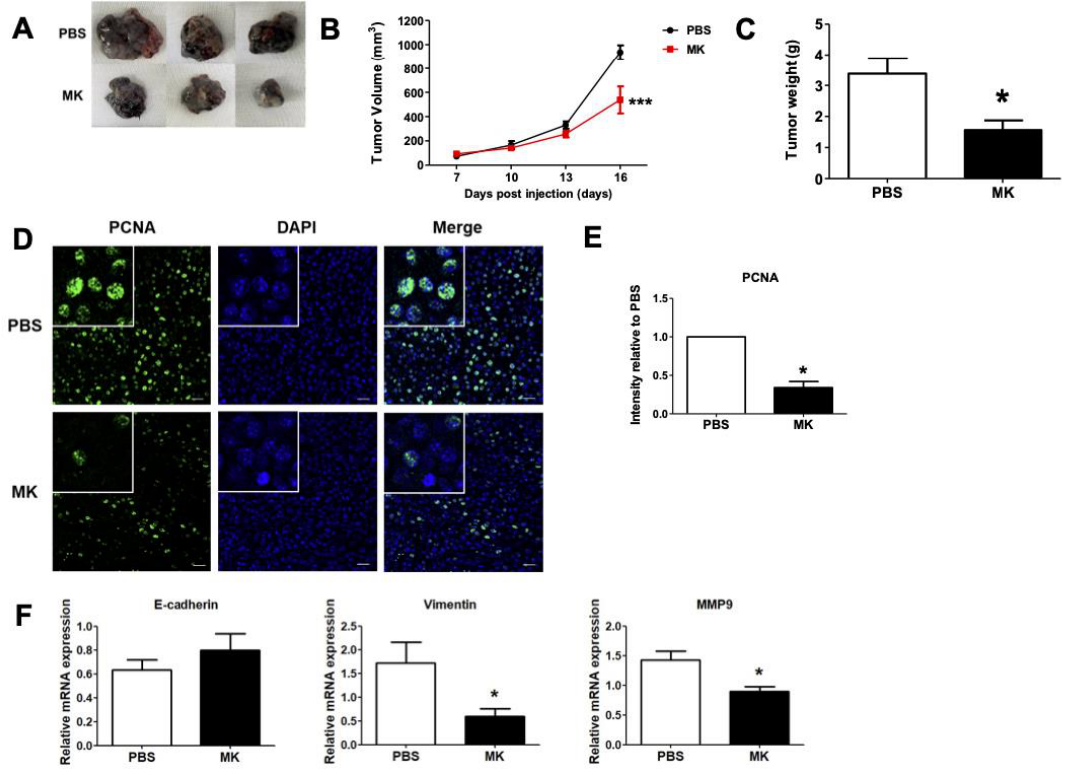
Figure 6. Inhibition of tumor growth by melittin–dKLA in a mouse model of melanoma. ( A ) Images show the tumor tissues from the mouse model. ( B ) The volume of the tumor was measured by a digital caliper and calculated using the formula V = (Width (2) × Length)/2. ( C ) The tumor weight of mice was measured by electronic scale after sacrifice. ( D ) Expression of PCNA in tumor tissues was determined by immunofluorescence staining assay. Confocal images of a tumor tissue slice stained for PCNA (green) and nucleus (DAPI; blue). ( E ) The graph is presented as intensity relative to PBS. ( F ) Expression of E-cadherin, vimentin, and MMP9 mRNA in tumor tissues was analyzed by quantitative real-time PCR. All data are presented as means ± SD ( n = 5); * p < 0.05, *** p < 0.0001 versus the PBS group, MK: melittin – dKLA.